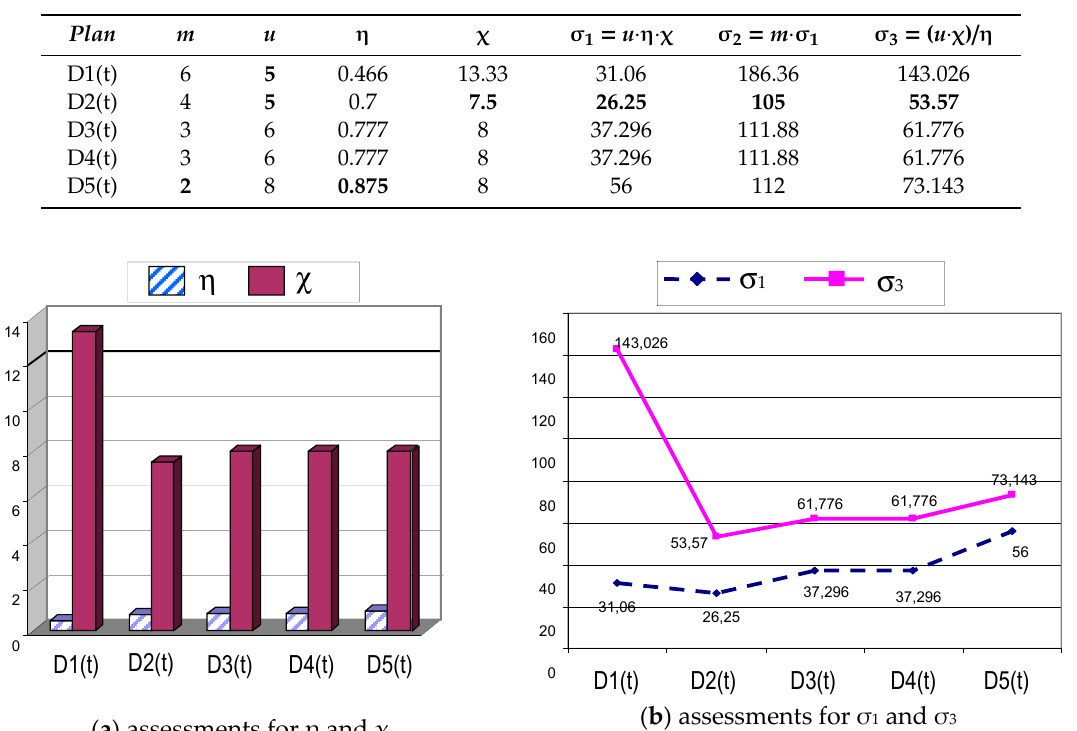
Table 5. Evaluation of the parameters of determined dispatching plans.